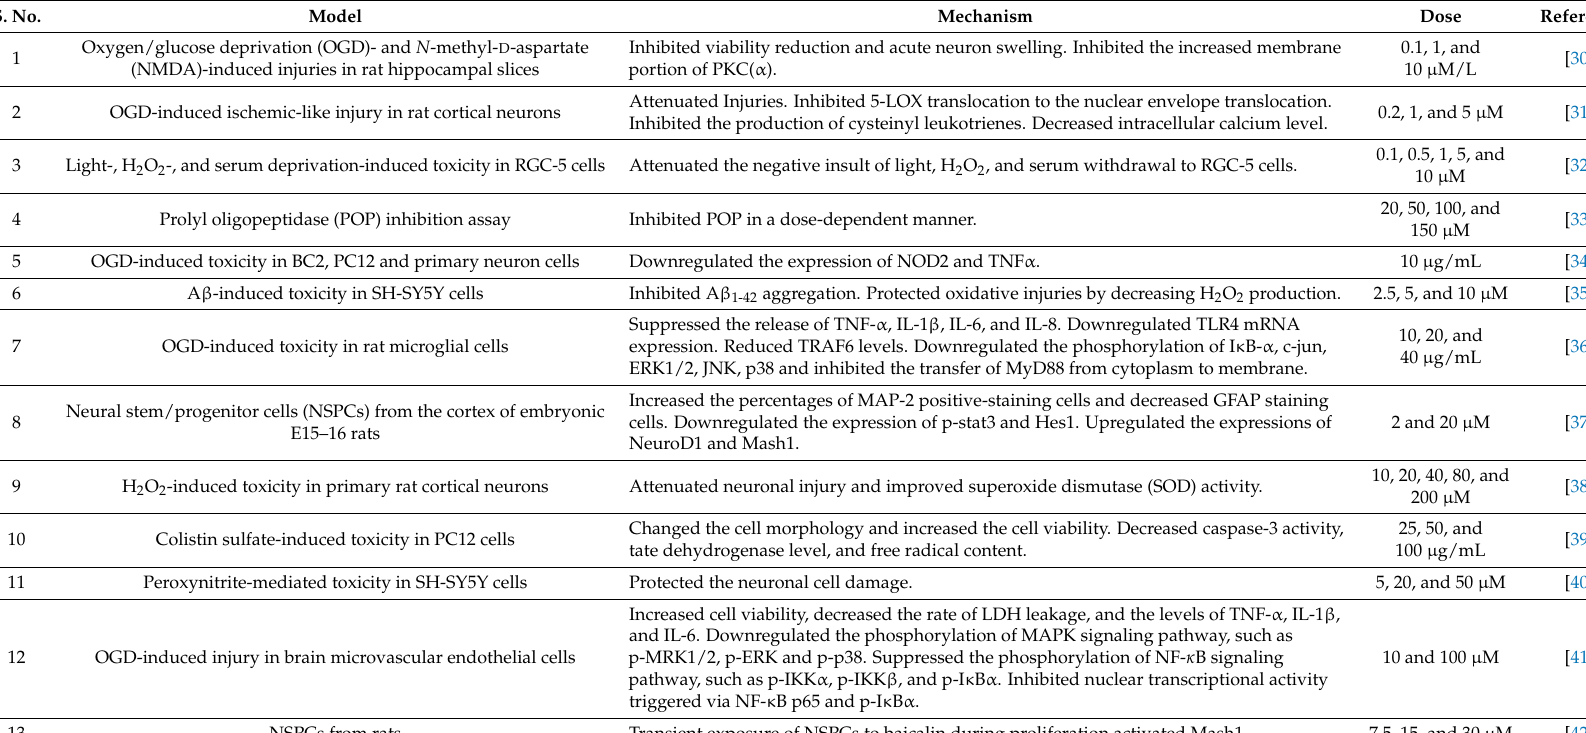
Table 1. Neuroprotective effects of baicalin under in vitro and ex vivo